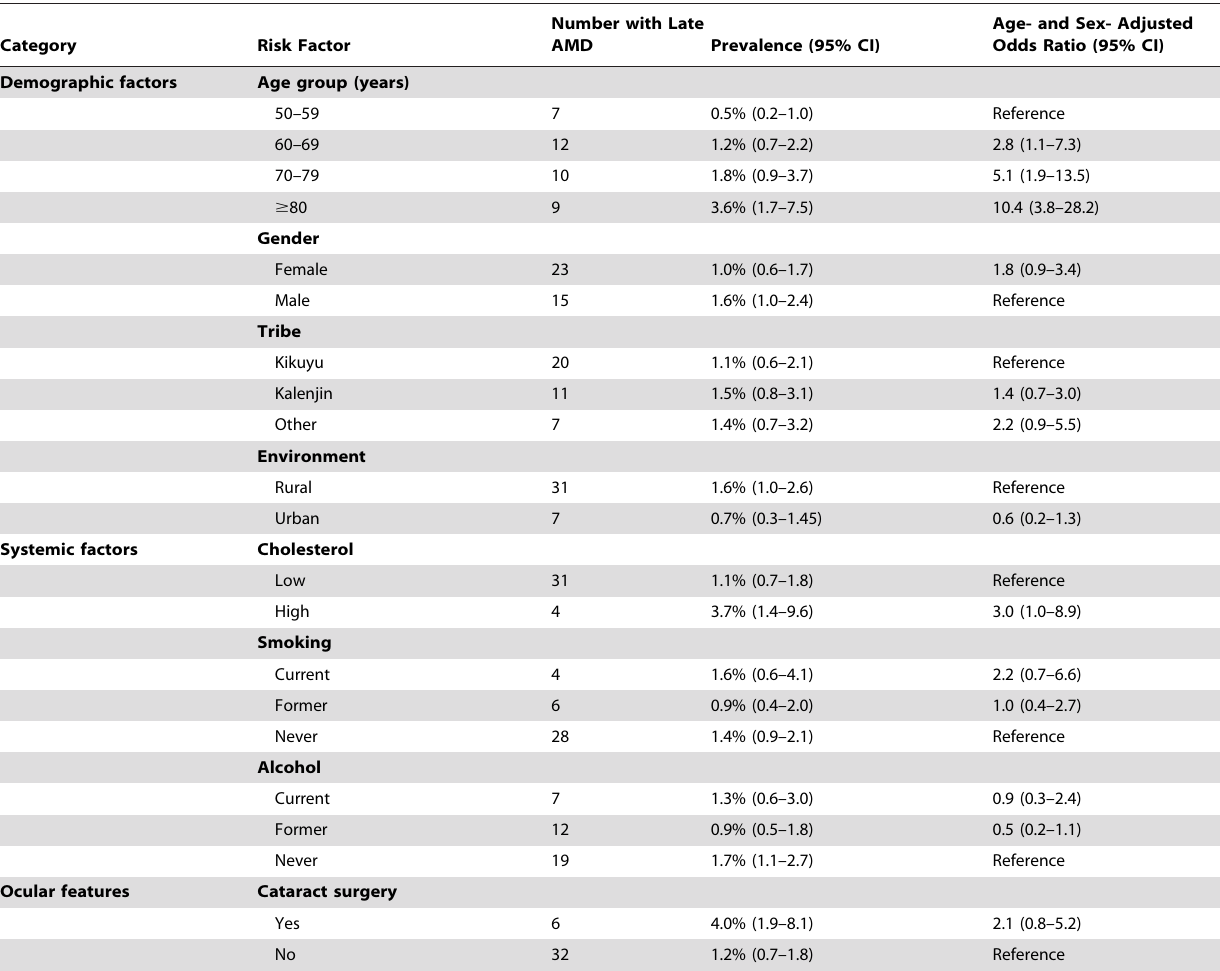
Table 7. Risk factors for late